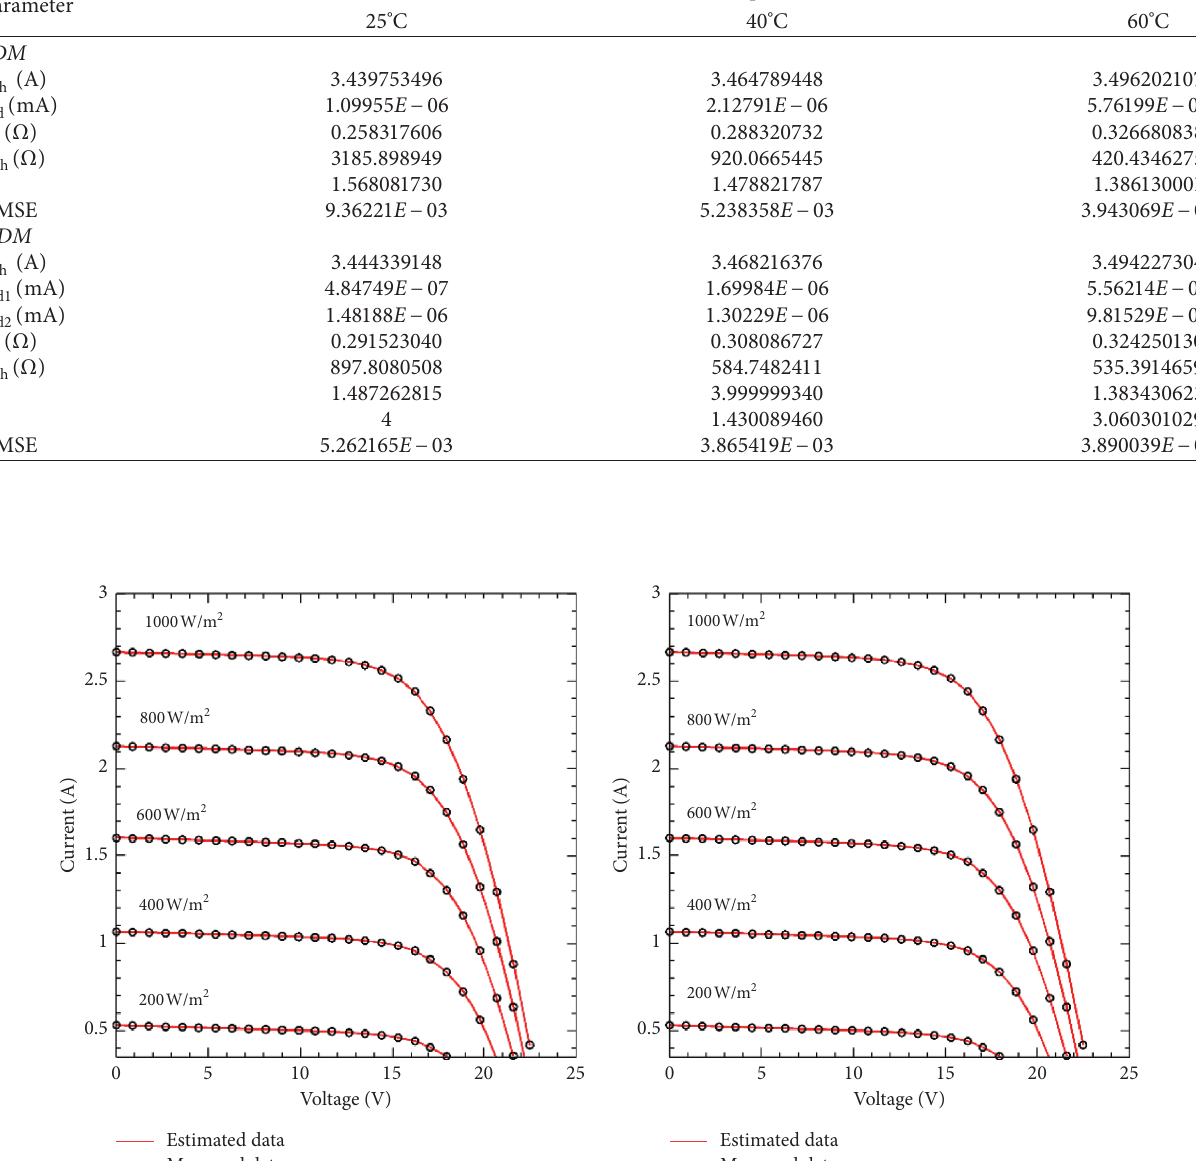
Table 13: The optimal extracted parameters for SM55 based on MWOA at various temperatures with irradiance of 1000 ( W/m 2 ) .